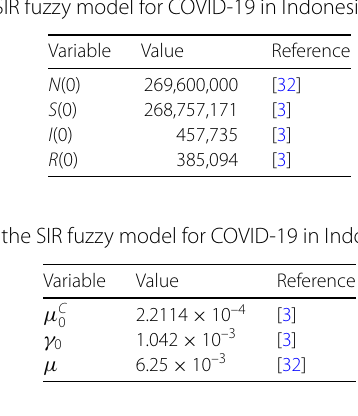
Table 3 Assumption parameter value and (cid:6) 0 value of the SIR fuzzy model for COVID-19 in Indonesia Simulation